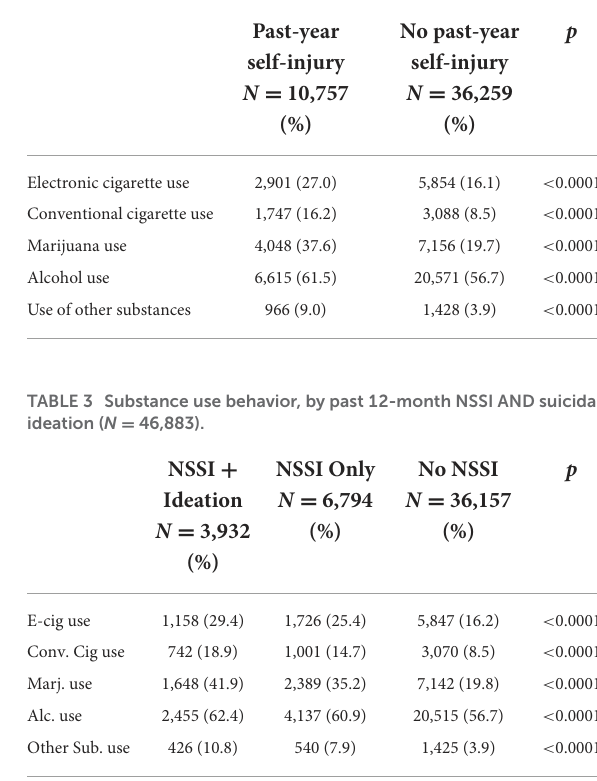
TABLE 2 Substance use behavior, by past 12-month self-injury.